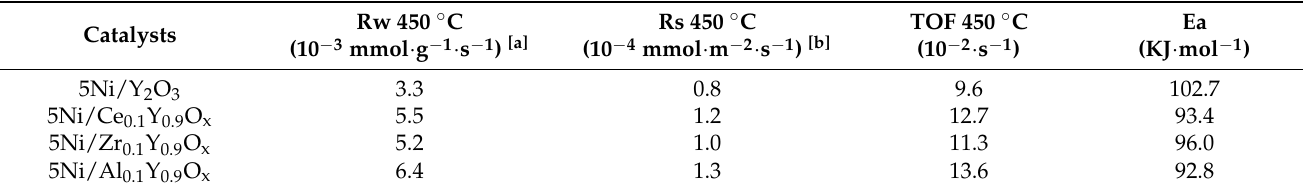
Table 1. DRM kinetics results of the catalysts.